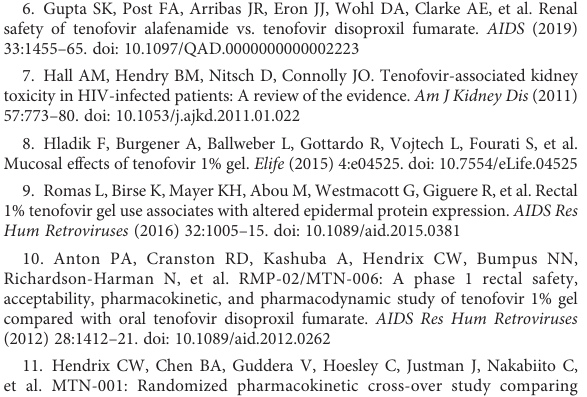
Impact of age on gene expression according to PrEP regimen. Treatment and control groups consisting of specimens collected from Uganda and South Africa were divided according to age into adolescents (up to 19 years of age) and adults (>19 years). Vulcano plots show the comparisons of foreskin transcripts within the drug groups, or the control arm. No DEGs related to the comparisons adolescents versus adults